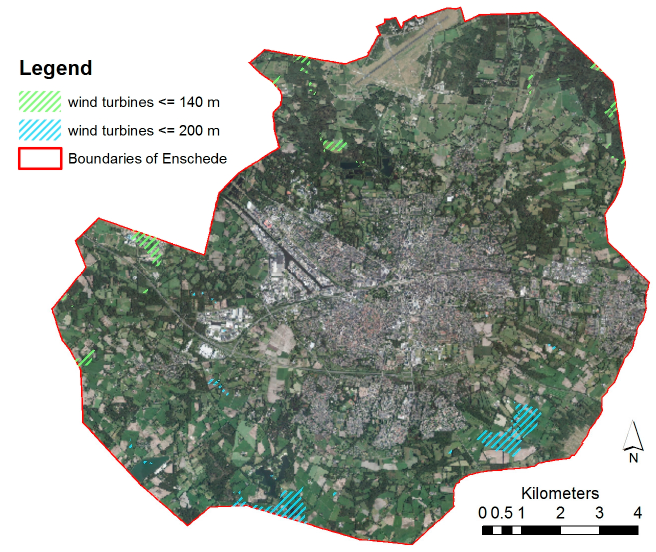
Figure 3. Area suitable for wind turbines in the city of Enschede.